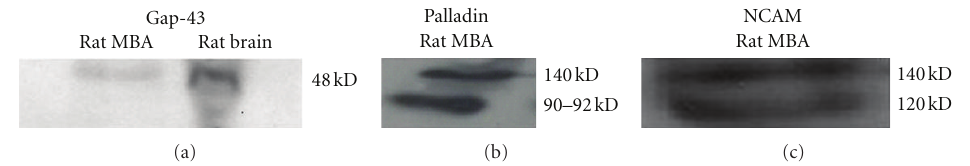
Figure 4: Western blot analysis of Gap-43, palladin, NCAM in adult rat MBA. Immunoblots from the rat MBA protein lysate also confirmed the presence of Gap-43 palladin and NCAM. Palladin expresses as two isoforms of 90–92 and 140 kD proteins. Gap-43 antibody detected a ∼ 48kDa protein, whereas anti-NCAM detected 120 and 140 kD proteins. (Representative of 3